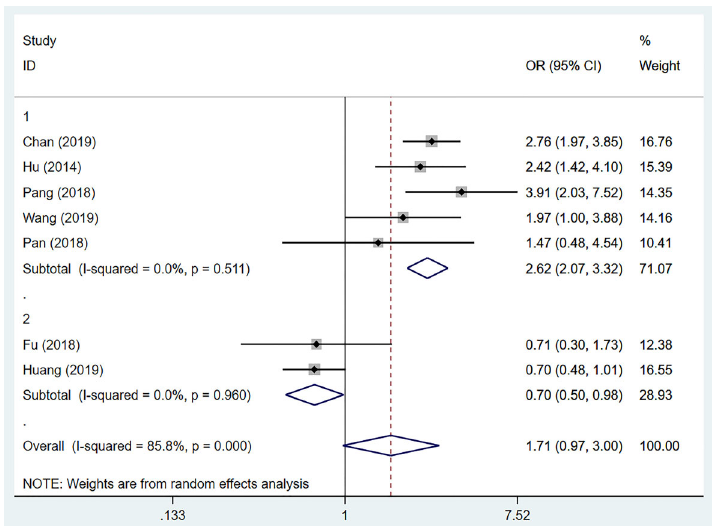
Figure 3. Subgroup analysis of the relationship between preoperative systemic immune-in fl ammation index (SII) and vascular invasion according to the preoperative SII cut-off value. See Supplementary Table S2 for reference numbers. Table 2. Results of subgroup analysis for preoperative systemic immune-in fl ammation index based on the cut-off value and the endpoint [vascular invasion (VI) and micro-vascular invasion (MVI)]. Factor Included HR 95%CI P value I 2 (%) P value for studies heterogeneity Cut-off value High cut-off value 5 2.62 (2.62 – 3.32) 0.00 0.0 0.511 Low cut-off value 2 0.70 (0.50 – 0.98) 0.04 0.0 0.96 Endpoint 3 2.82 (2.18 – 3.66) 0.00 0.0 0.523 1.04 (0.59 – 1. 6) 0.883 62.5 0.046 VI, vascular invasion; MVI, micro-vascular